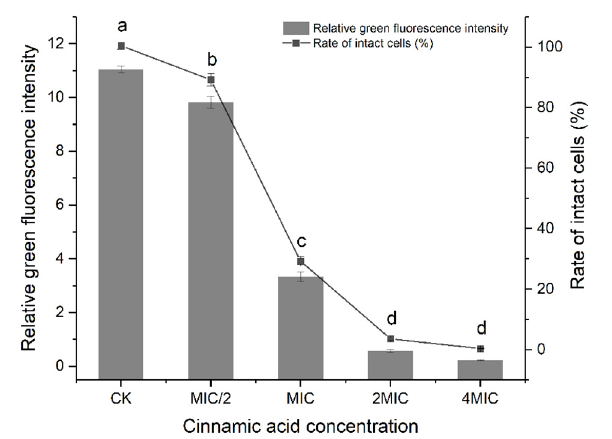
FIGURE 3 | Effect of cinnamic acid at different concentrations on the membrane integrity of S. maltophilia 4–1. CK represents the group without citral. Bars with different letters differ significantly ( p < 0.05) by Duncan’s test. All experiments were performed in